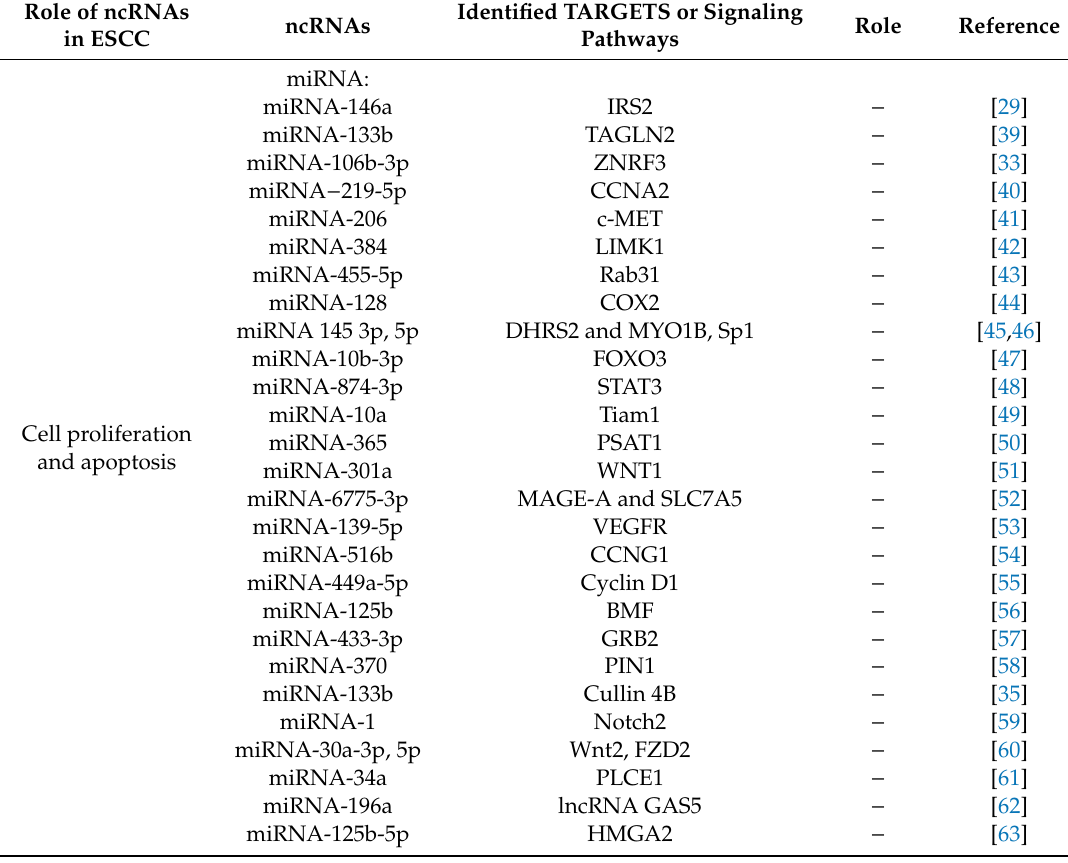
Table 1. Regulatory non-coding RNAs (ncRNAs) in ESCC